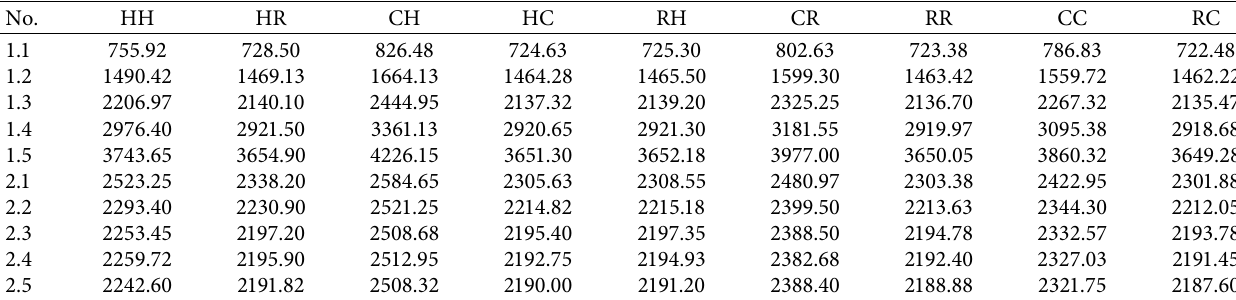
Table 14: Mean lengths of schedules returned by the LS algorithms for the benchmark given in [9] with cov � 90%. No. HH HR CH HC RH CR